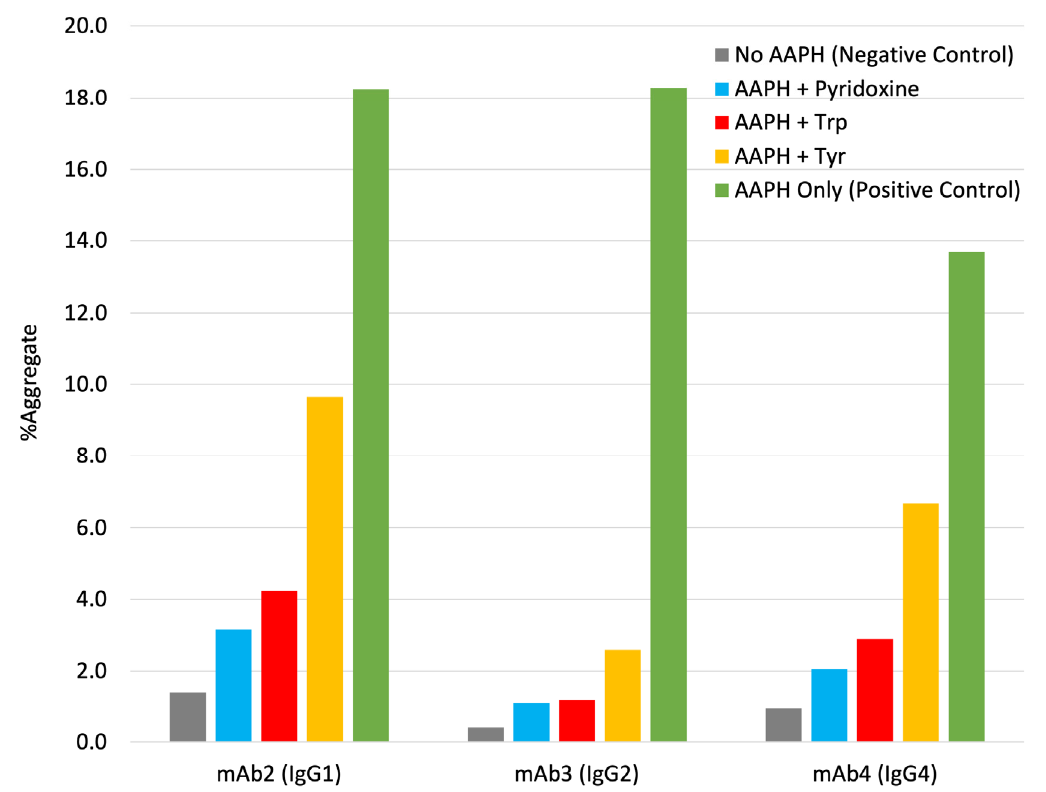
Figure 7. Aggregation of various mAbs under 1 mM AAPH stress after 72 h at 40 ◦ C. Grey bar: no AAPH stressed mAb (negative control); light blue bar: AAPH stressed mAb containing pyridoxine; red bar: AAPH stressed mAb containing Trp; yellow bar: AAPH stressed mAb containing Tyr; green bar: AAPH stressed mAb without aggregation inhibitors (positive